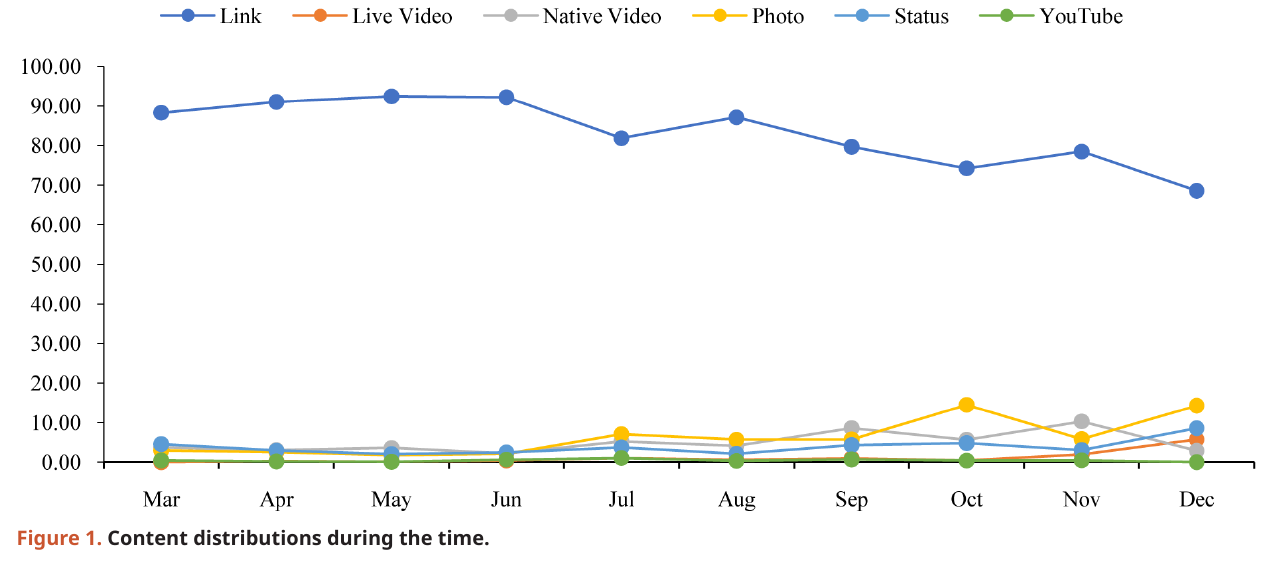
Figure 1. Content distributions during the time.